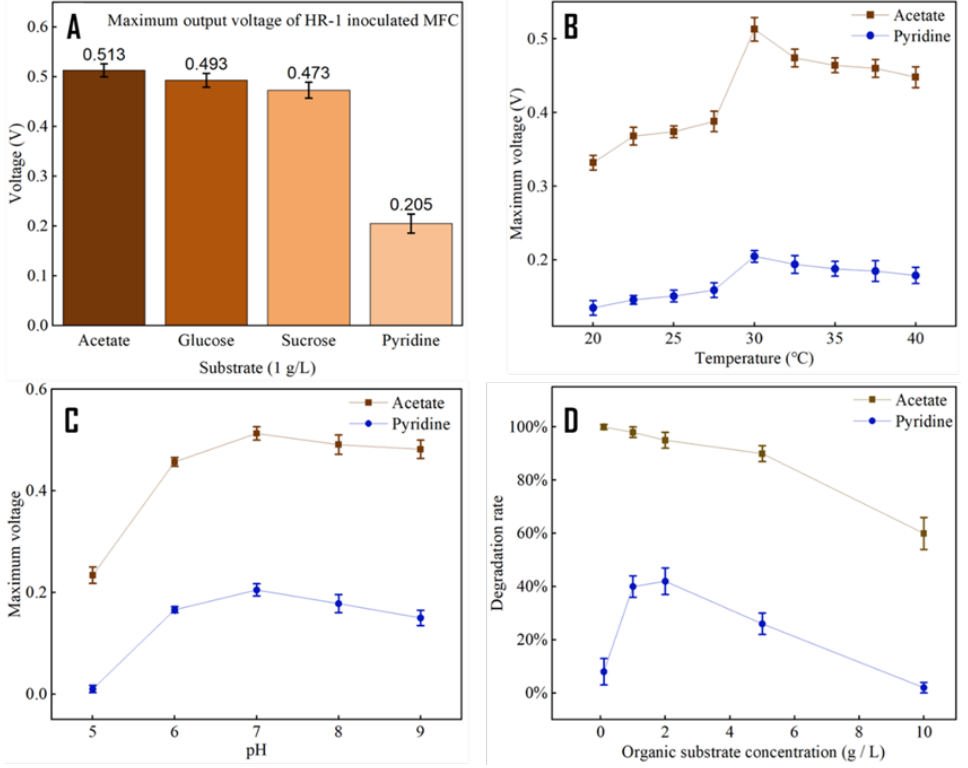
Figure 4. ( A ) Substrate availability of HR-1-inoculated MFC, the concentration was 1 g/L; ( B ) Maximum voltage of HR-1-inoculated MFC with acetate and pyrimidine under different temperature, the range was from 20 – 40 °C, the concentration was 1 g/L; ( C ) Maximum voltage under different pH, the range was from 5 – 9, with 1 g/L concentration; ( D ) Relationship between initial concentration and degradation rate, the operation condition was temperature at 30 °C and neutral. Optimal temperature and pH were tested with acetate and pyridine as the substrate, respectively. In 1 g/L initially, HR-1-inoculated MFC generated electricity in a wide range of temperature from 20 °C to 40 °C (Figure 4B). In the acetate-fed MFC, when temperature was higher than 30 °C, the output was above 400 mV (445, 435.7, 432.6, and 421 mV, re-